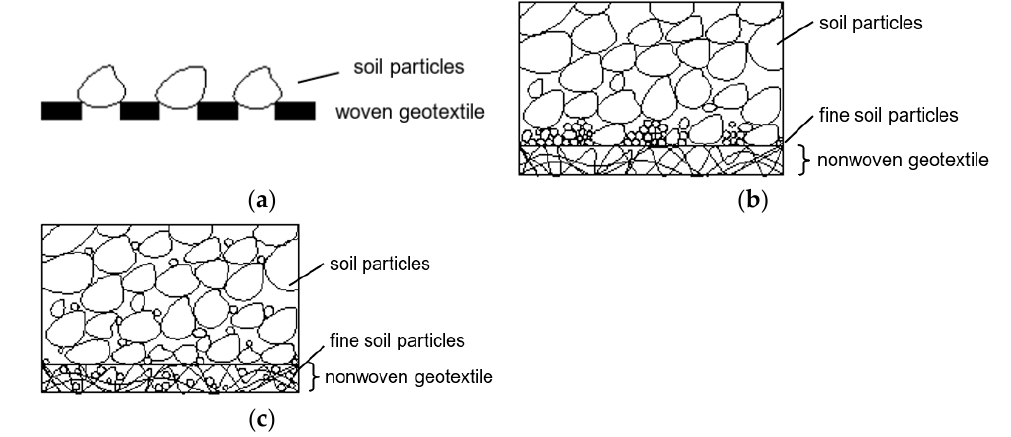
Figure 9. Blocking ( a ); blinding ( b ); and internal clogging ( c ) of geotextile filter.